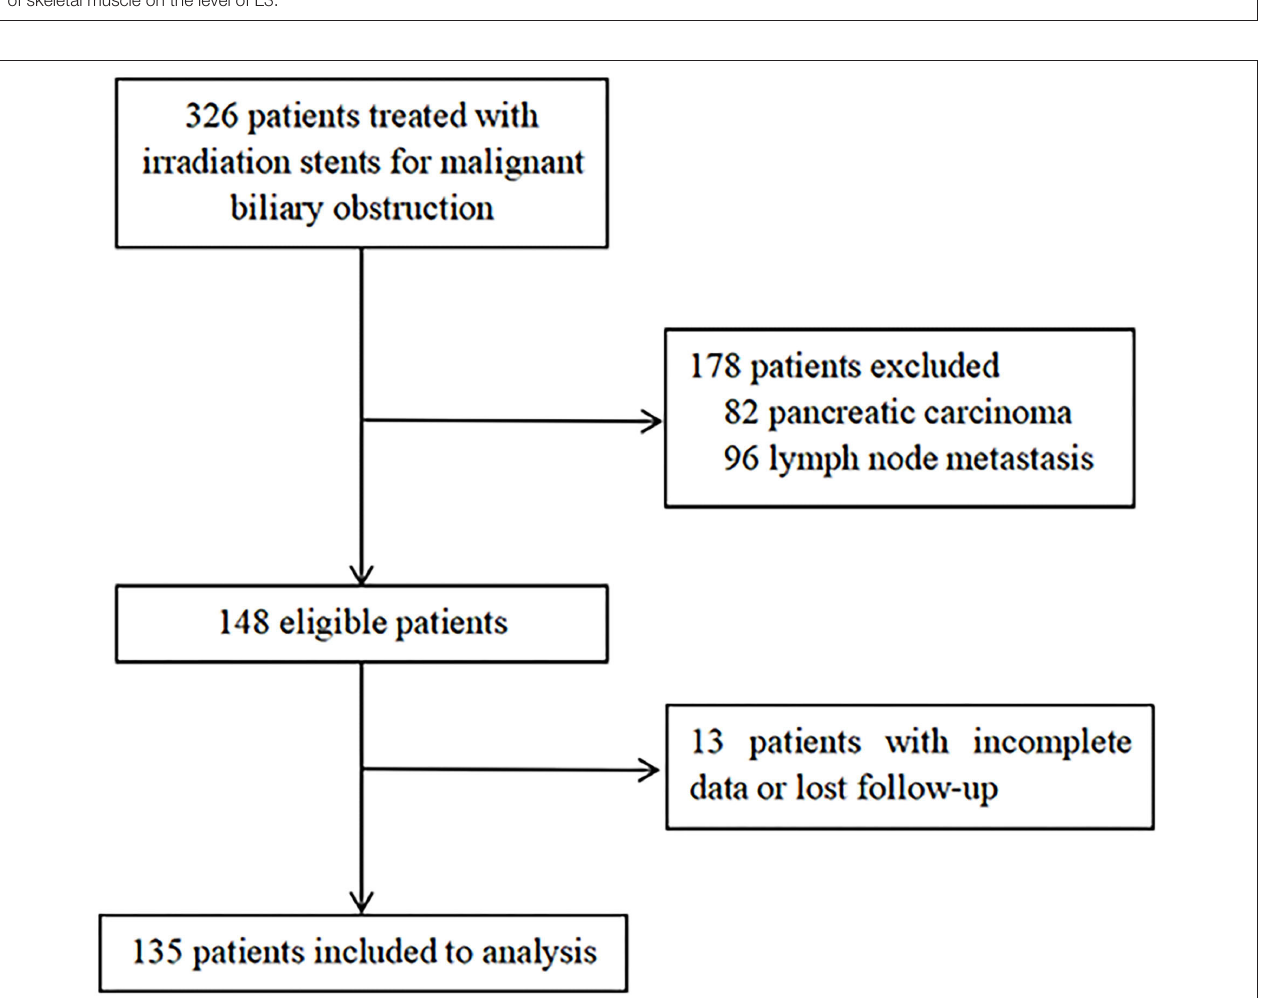
FIGURE 2 | The flow diagram of patient